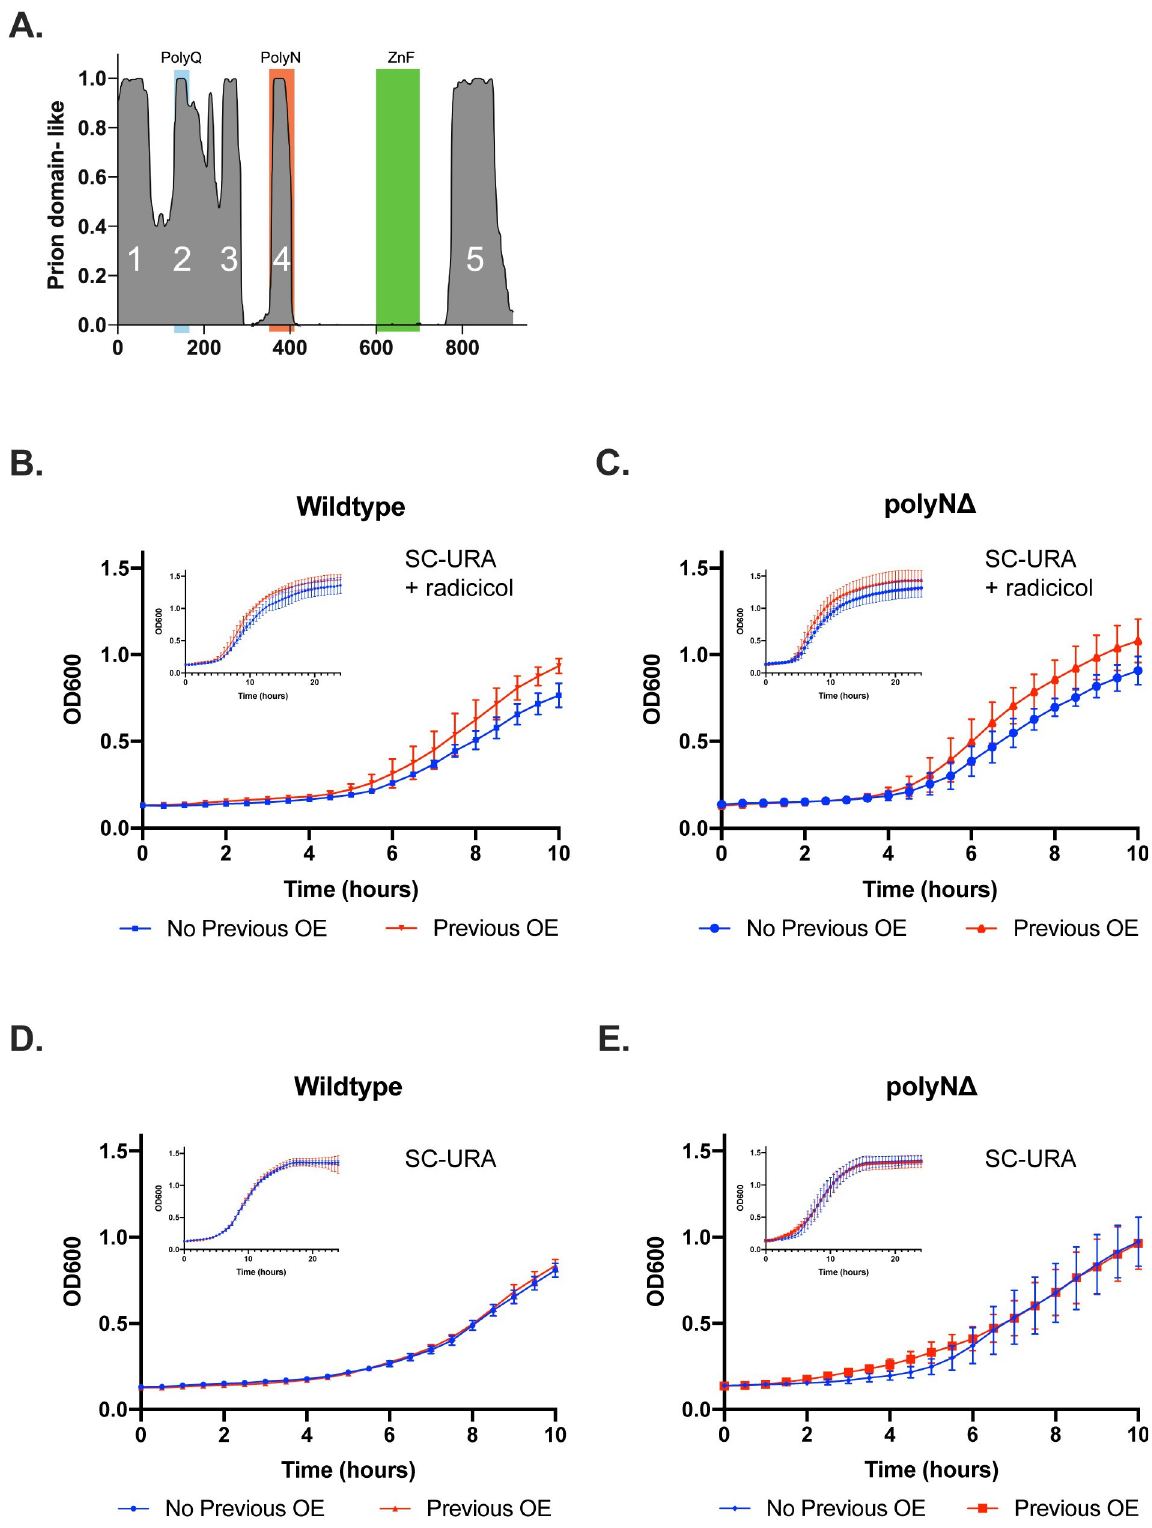
Fig 5. Role of the polyN domain in prion formation and activity. A) Azf1p domains predicted to be capable of promoting prion formation by PLAAC. The polyQ and polyN domains of Azf1p are both predicted to have prion-like properties. B) Growth of WT cells that did (red) and